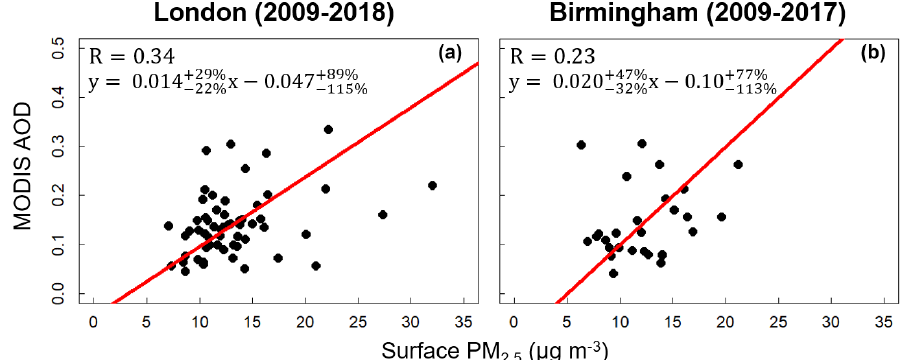
Figure 4. Assessment of MODIS AOD with surface PM 2 . 5 in London (a) and Birmingham (b) . Points are monthly means of city-average AOD from MODIS and PM 2 . 5 from surface networks for London and Birmingham. The red line is the SMA regression. Values inset are Pearson’s correlation coefficients and regression statistics. Relative errors on the slopes and intercepts are the 95% CI.